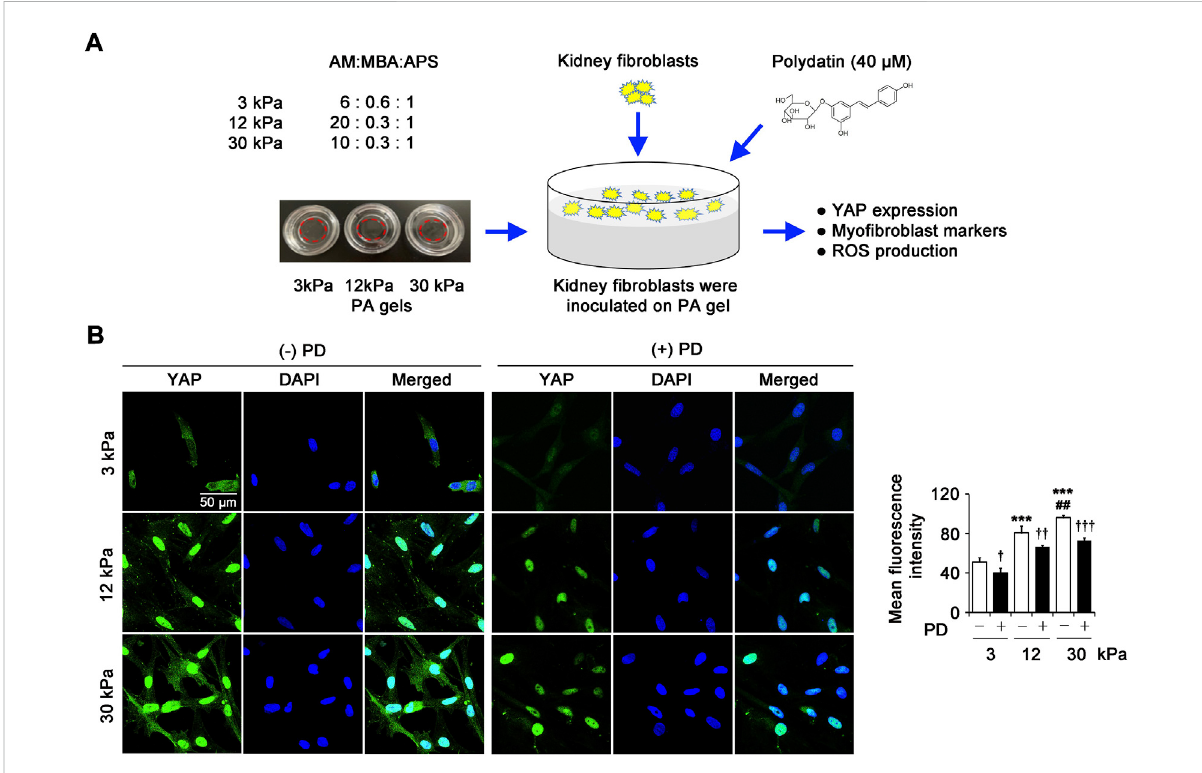
FIGURE 3 PD inhibits pathological matrix stiffness-induced YAP expression in renal fi broblasts. (A) The schedule of exploring the effect of PD on renal fi broblasts in vitro on PA gels with different matrix stiffness. (B) Confocal laser scanning microscopy (CLSM) shows YAP in the renal fi broblasts cultured on PA gels with different stiffness (3 kPa, 12 kPa and 30 kPa) for 24 h. Treatment with PD (40 μ M) results in a dramatically reduced levels of YAP. AM, Acrylamide; MBA, N,N ’ -methylenebisacrylamide; APS, ammonium persulfate; PA gel, polyacrylamide hydrogel; PD, polydatin;